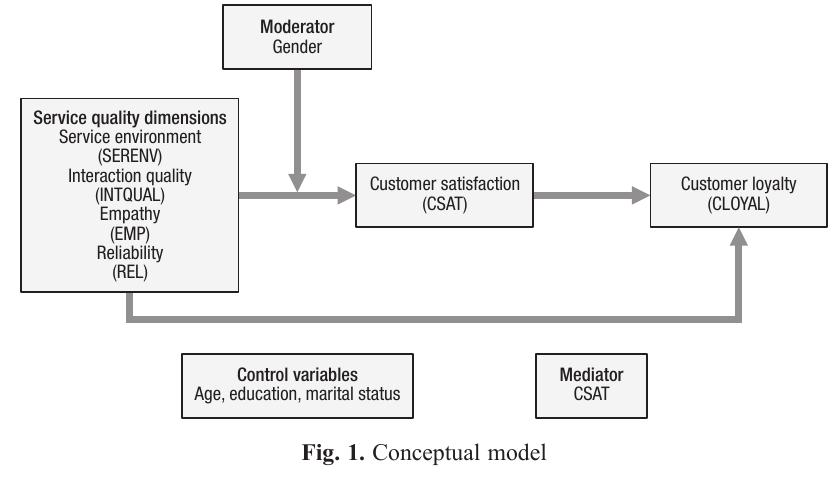
Fig. 1. Conceptual model